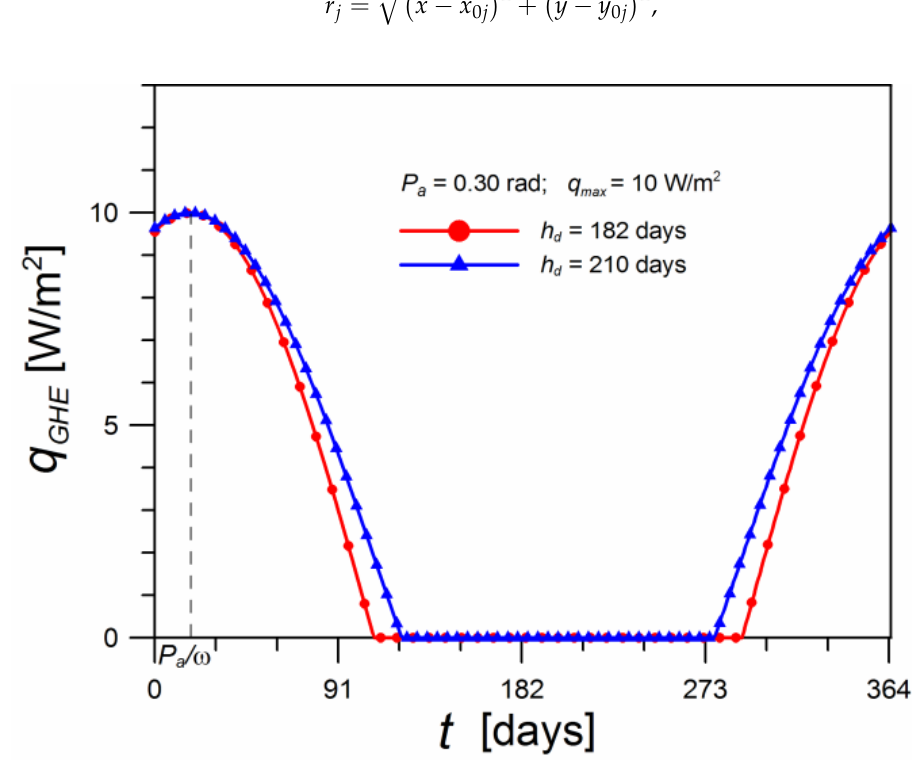
Figure 6. Exemplary time courses of heat flux extracted from the ground.